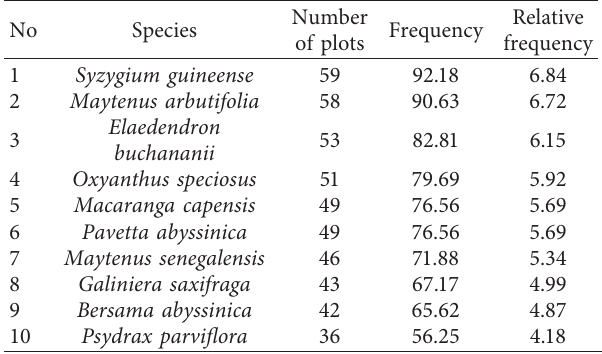
Table 6: Frequency distribution of some tree/shrub species of Wurg